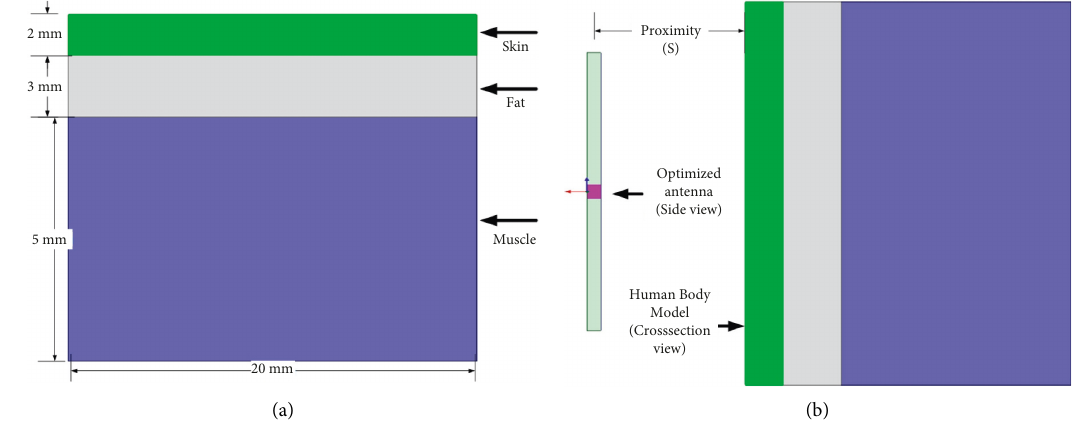
Figure 11: (a) Human body model and its dimensions and (b) placement of the optimized antenna in variable proximity ( S